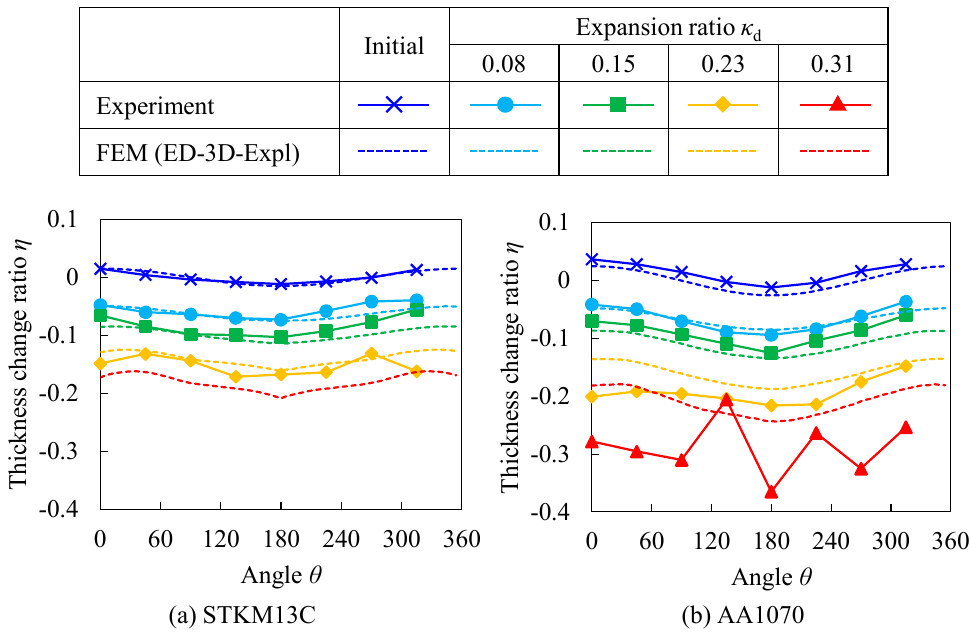
Figure 17. Effect of expansion ratio κ d on ovality ratio ω .